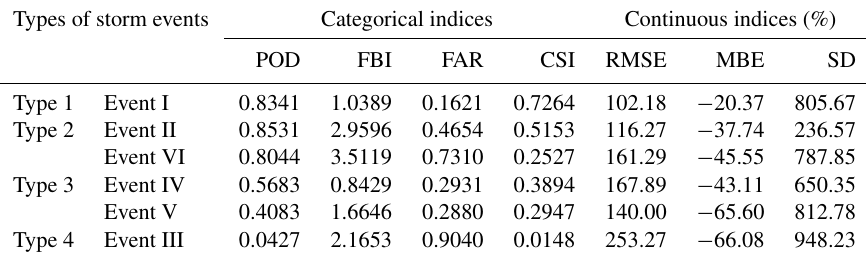
Table 8. Average index values of the 16 members of the physical ensemble for the simulations of the temporal rainfall patterns. Types of storm events Categorical indices Continuous indices (%)